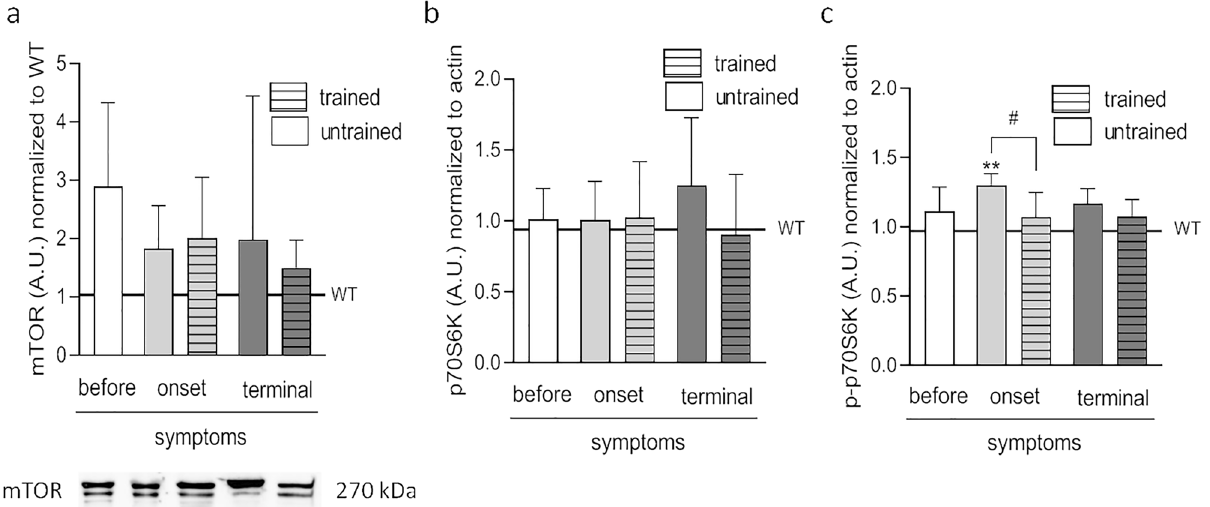
Figure 3. Effects of ALS disease progression and swim training on the proteins involved in the process of muscle protein synthesis. mTOR (a) , p70S6K (b) , p-p70S6K (c) were measured in the tibialis anterior muscle. There were significant differences between the groups: **p < 0.01 vs. WT group of mice, # p < 0.05 between indicated group, The data are presented as the means ± SEM (n = 5 in each group). Full-length blot is displayed in Supplementary Fig.